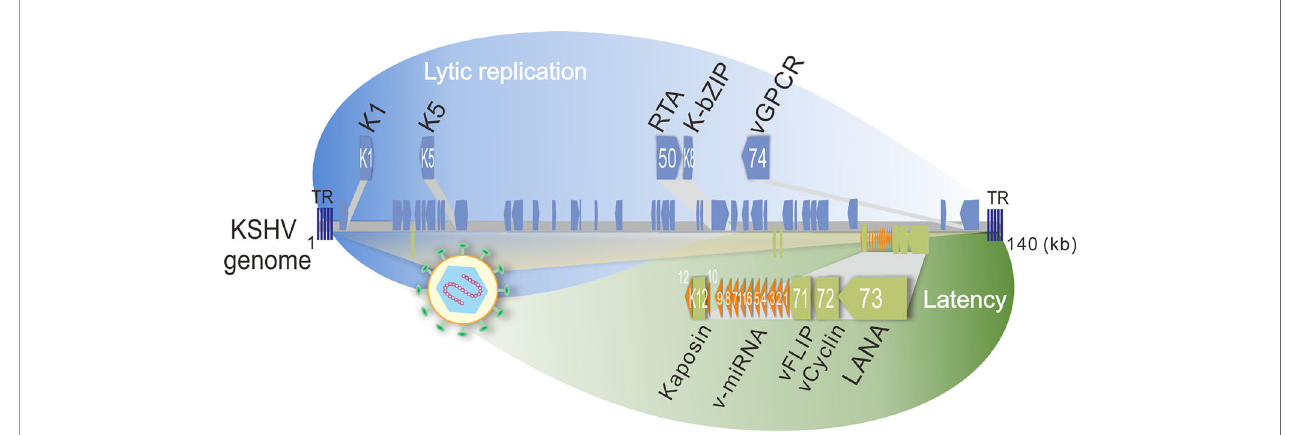
FIGURE 2 | Schematic representation of KSHV-encoded proteins that involve in host energy metabolism reprogramming during latency and lytic replication. The lytic genes (K1, K5, orf50, K8, and orf74 which encodes K1, K5, RTA, K-bZIP, and vGPCR, respectively) are shown on the top panel, and the latent genes (K12, v-miRNA, orf71, orf72, and orf73 which encodes Kaposin, v-miRNA cluster, vFLIP, vCyclin, and LANA, respectively) are shown at the bottom panel. TR, terminal repeat; kb, kilo base